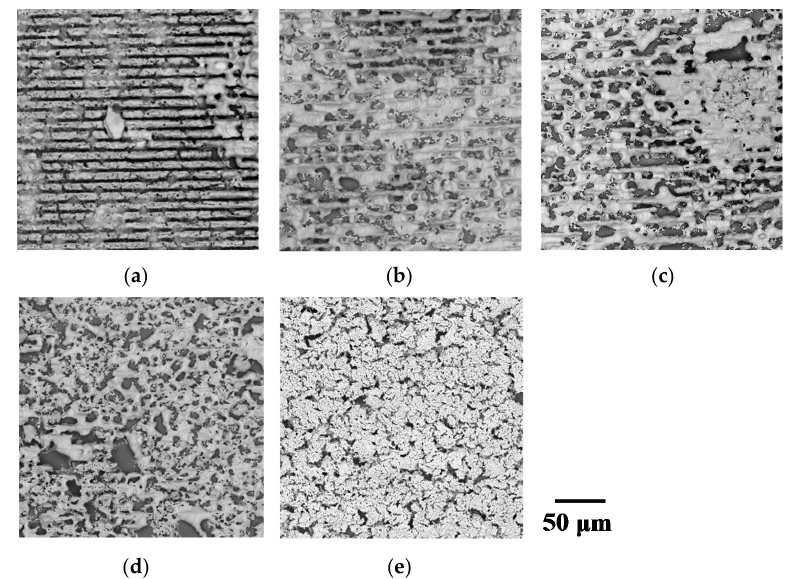
Figure 1. SEM images of micropatterns fabricated at writing speeds of ( a ) 100 µ m/s, ( b ) 500 µ m/s, ( c ) 1000 µ m/s, ( d ) 3000 µ m/s, and ( e ) 5000 µ m/s,